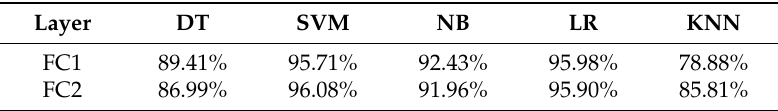
Table 16. Computed F1-score .